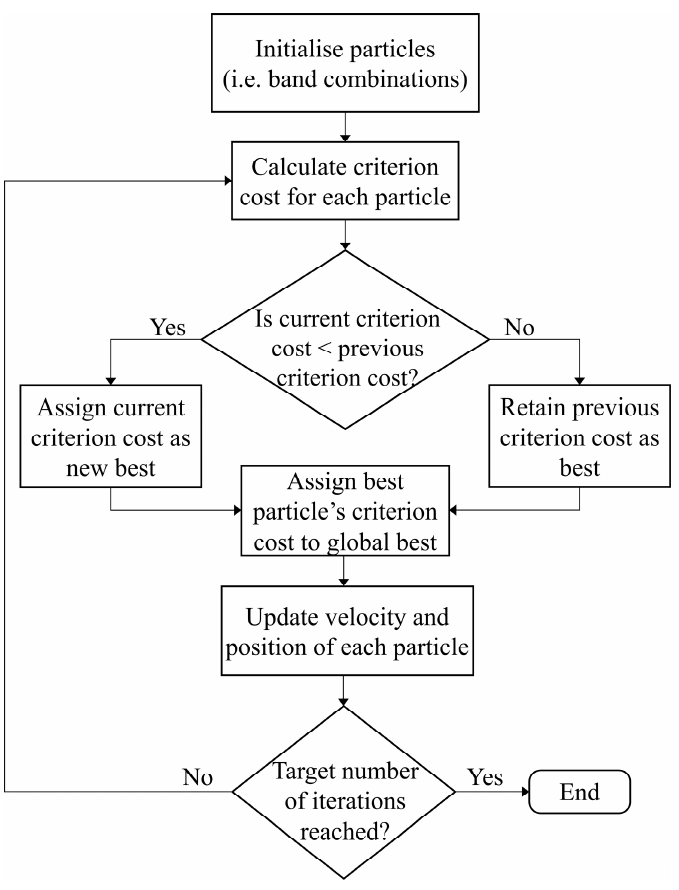
Figure 2. The method for the PSO-MEAC system. The algorithm initializes a set of particles or a combination of bands; at each iteration, the cost function (MEAC) associated with individual particles is computed; trajectories of the particles are projected towards the particle with the best solution; the loop is exited after the specified number of iterations is reached. The particle with a minimum cost function is identified as the optimal solution.